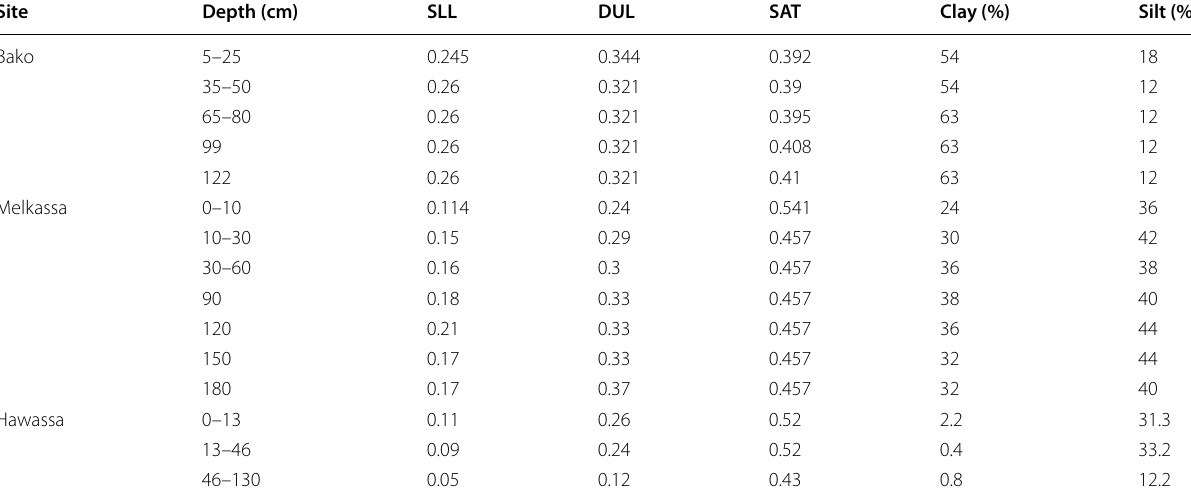
Table 2 Soil properties of the study areas used for the DSSAT model. Source: Kassie et al. (2014), Araya et al. (2015)